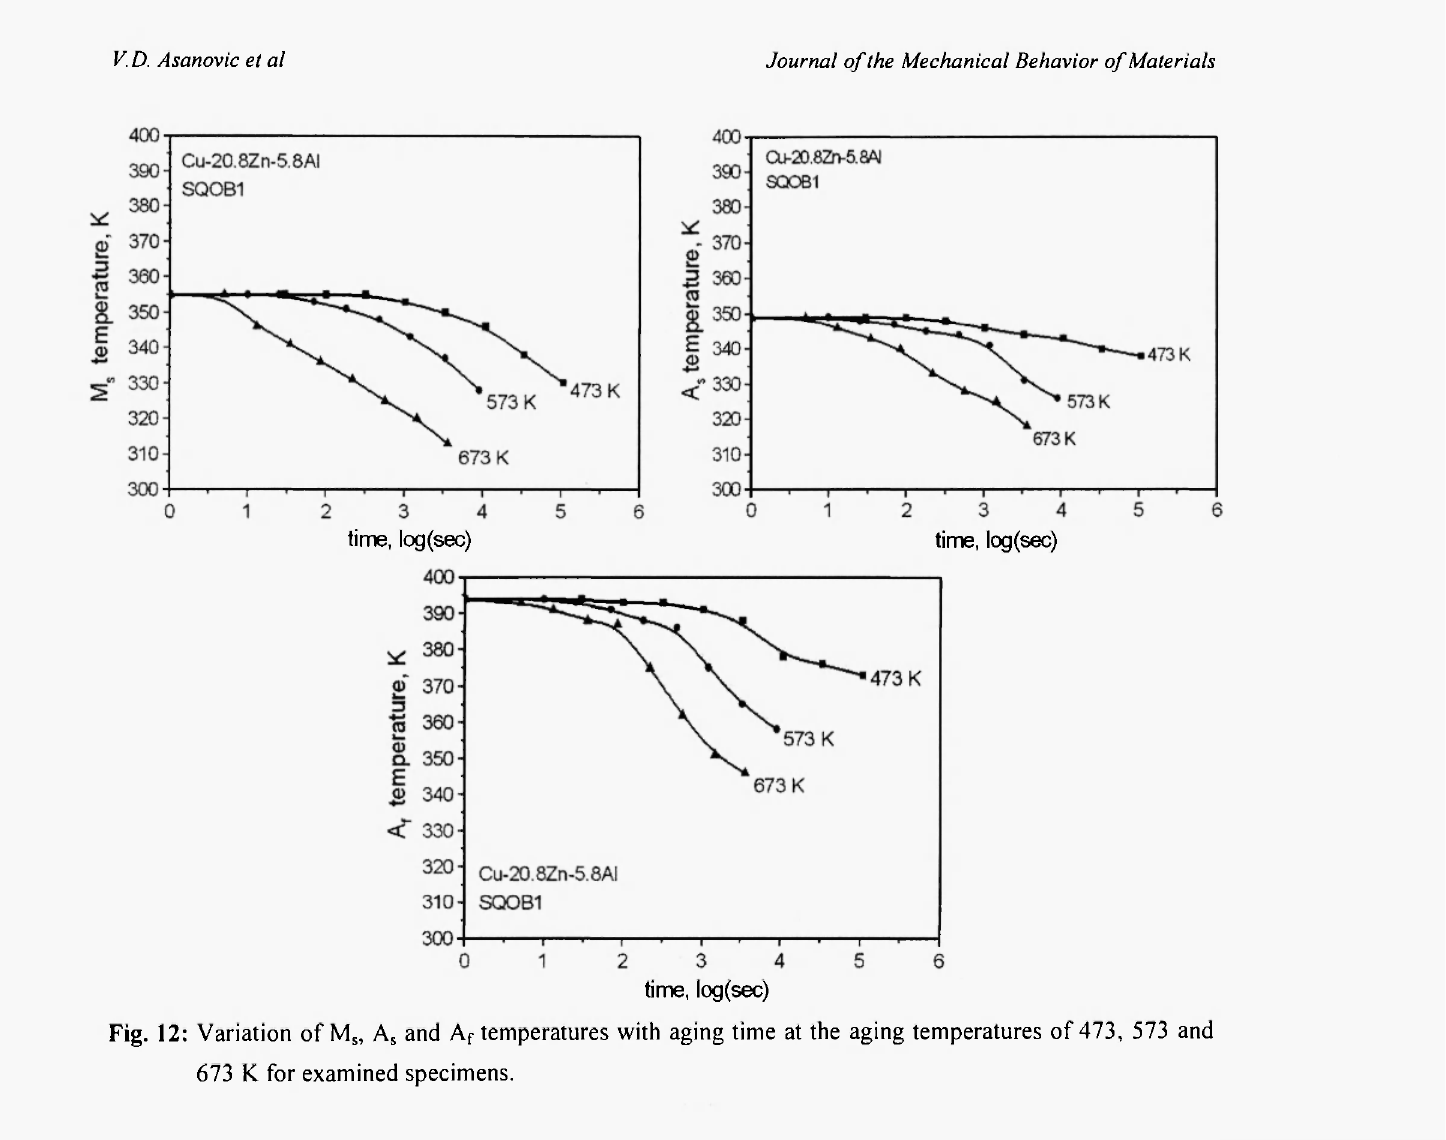
Fig. 12: Variation of M s , A s and A f temperatures with aging time at the aging temperatures of 473, 573 and 673 Κ for examined